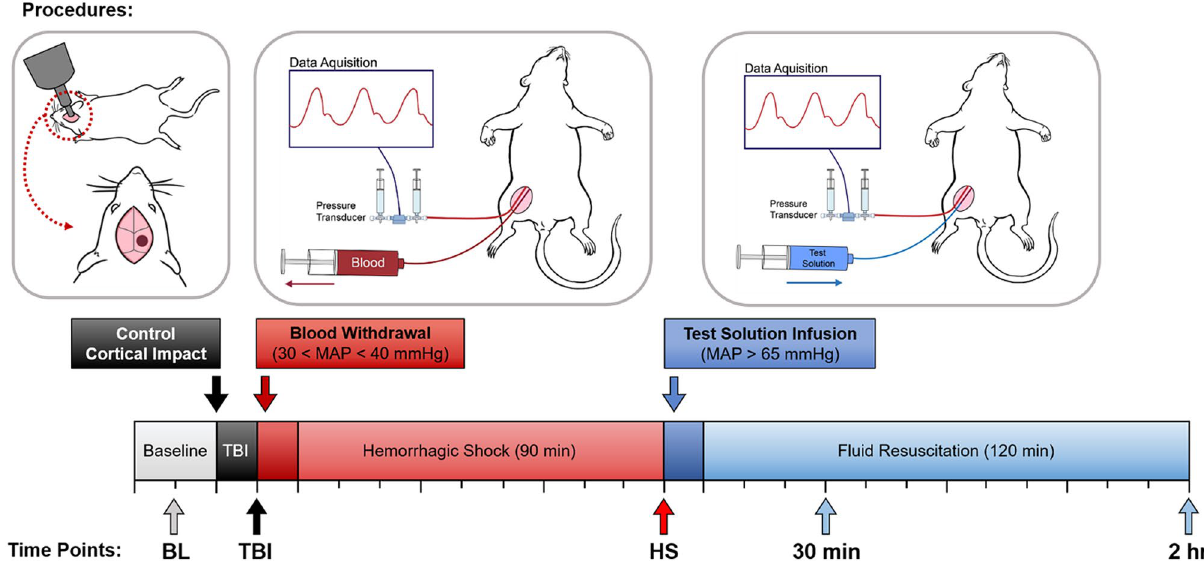
Figure 5. Representative timeline for the experimental